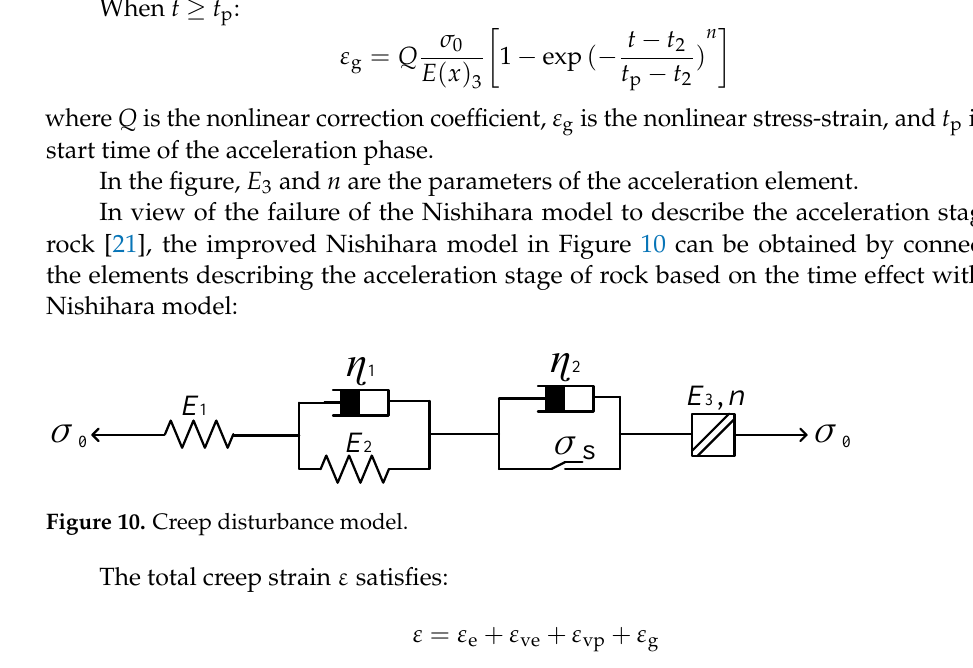
Figure 9. Nonlinear element.